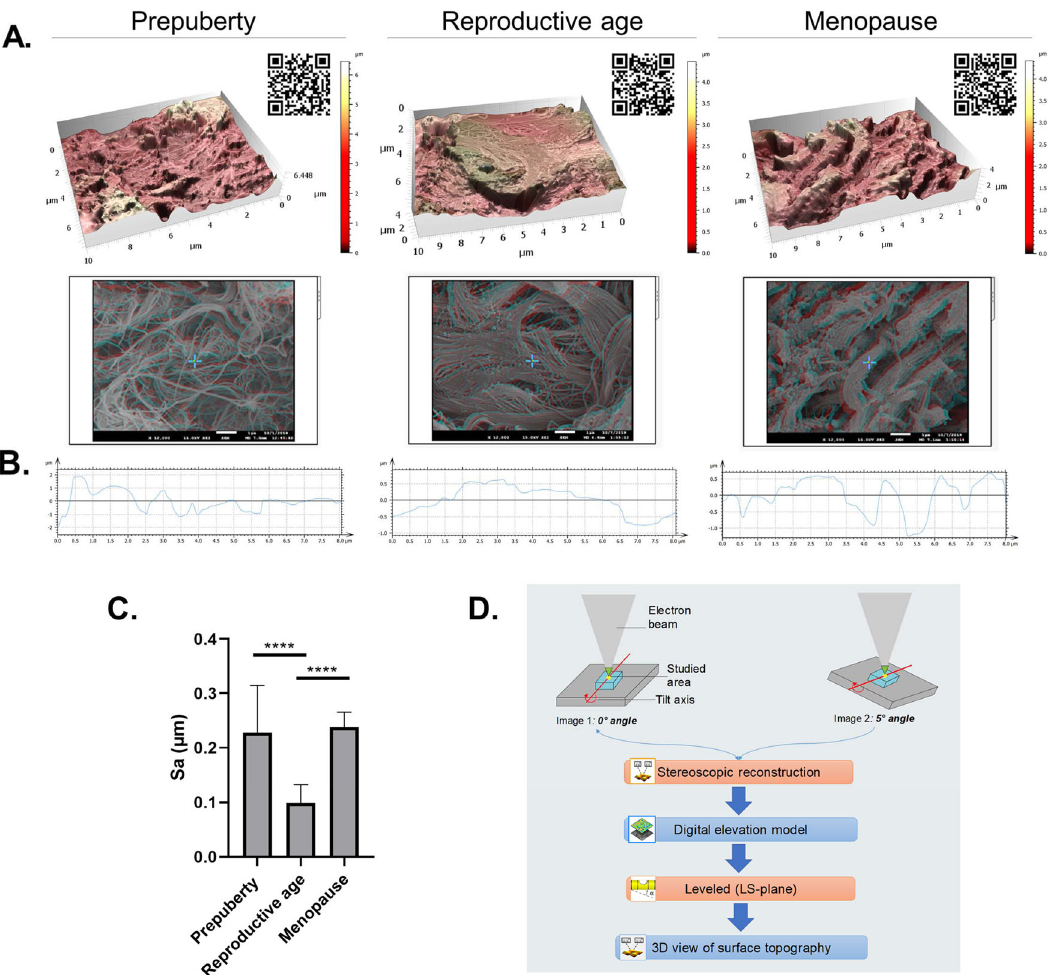
Fig. 6 Topography and surface analyses. A , D 3D rendering of surface topography from stereoscopic reconstruction of two SEM images acquired using eucentric rotation around the y axis with a 5° tilt at ×12,000 magni fi cation. Color scales indicate the height range on each surface. Scale on SEM micrographs corresponds to 1 µ m. QR codes open video animation of 3D topography representations. B Extracted rugosity pro fi les from 3D reconstructions. C Surface roughness was measured by calculating the arithmetic average of 3D roughness (Sa) according to calculation conditions de fi